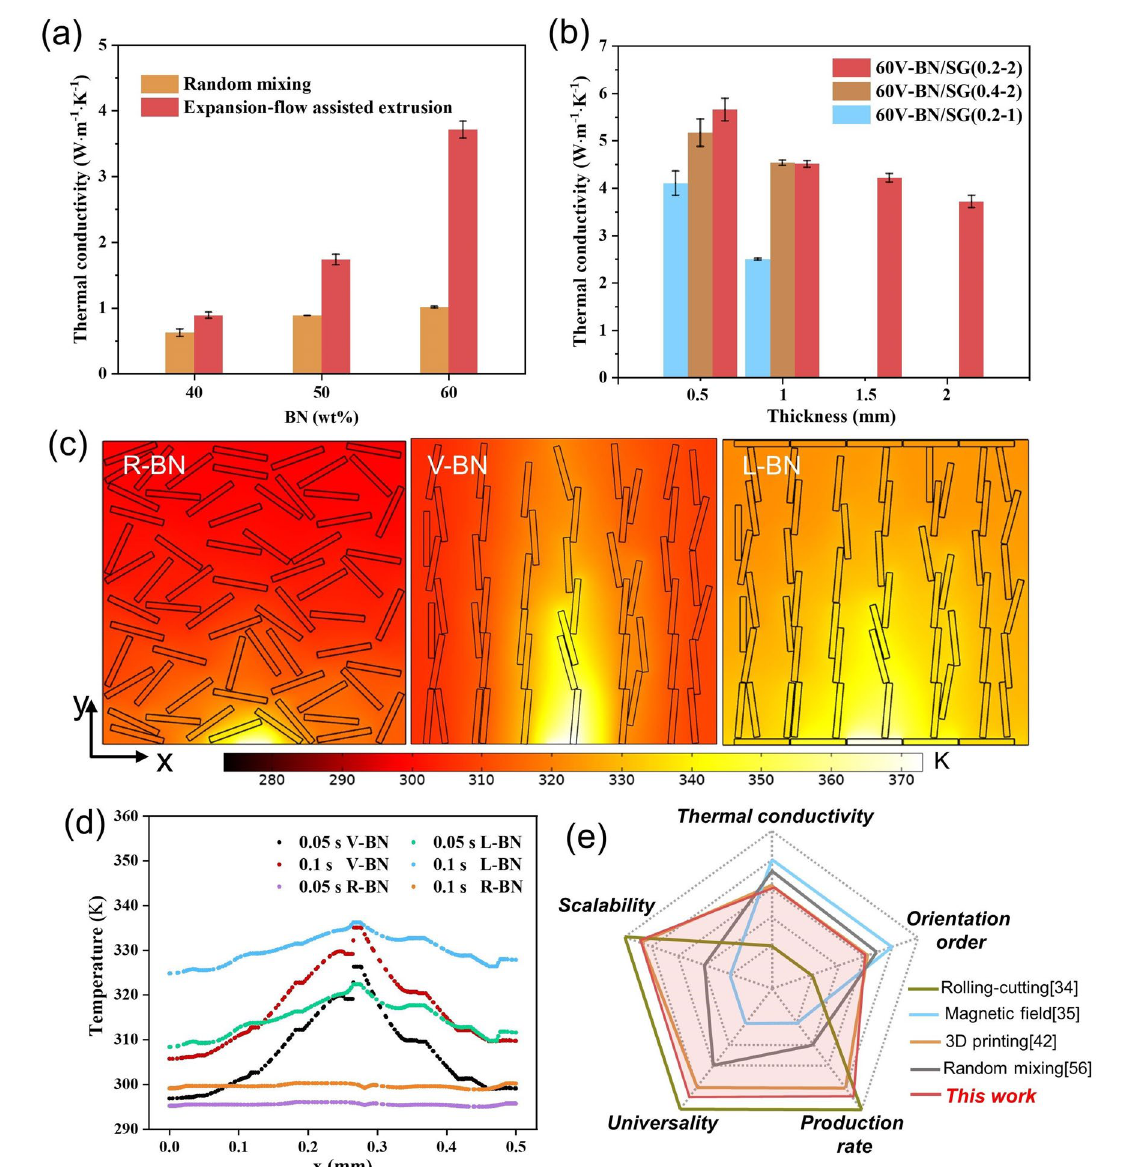
Fig. 6 Thermal conductivity of V-BN/SG strips. a Through-plane thermal conductivity of BN/SG strips as a function of filler loading. b Through-plane thermal conductivity of V-BN/SG strips fabricated by three kinds of molds as a function of sample thickness. c Simulated com- parison of heat transfer of randomly dispersed BN (R-BN), vertically aligned BN (V-BN), and ladder-structure BN (L-BN) assembly heated by a localized heat source for 0.1 s. d Temperature distribution at the half-height of these three simulated boxes. e Qualitative comparison of our work with reported ones regarding the BN composites fabrication [34, 35, 42,